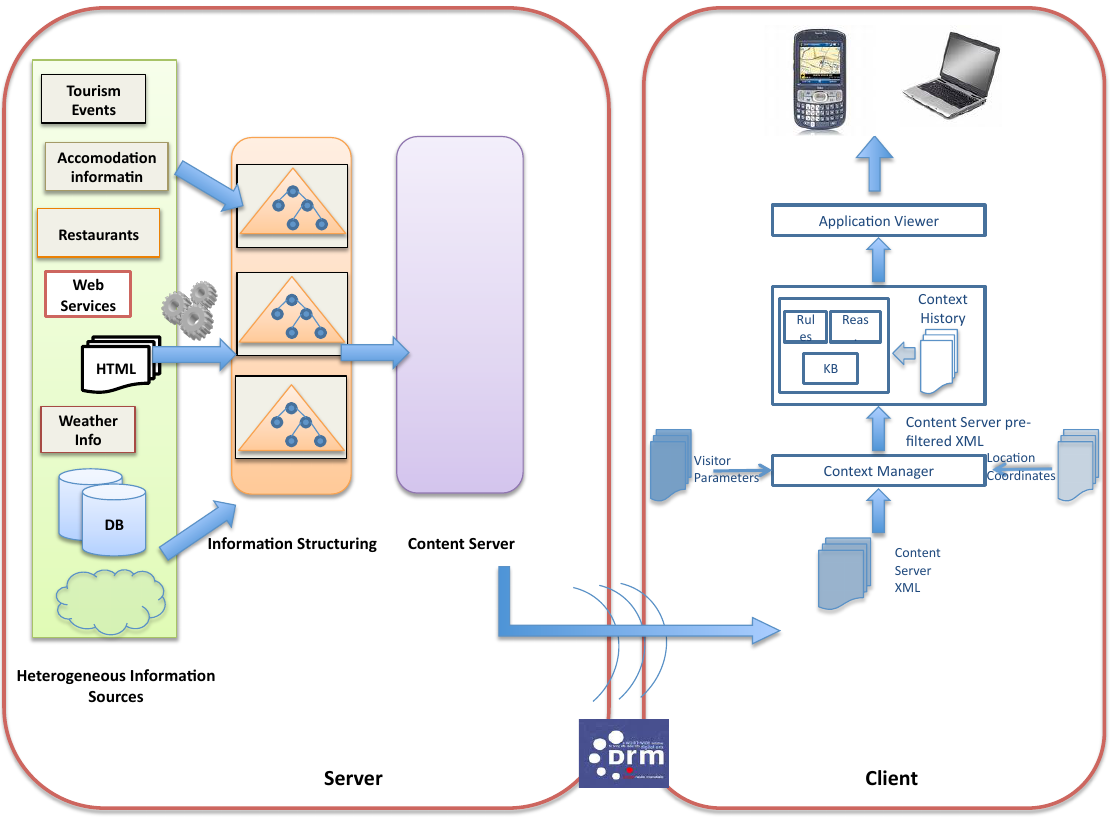
Figure 5. CONCERT